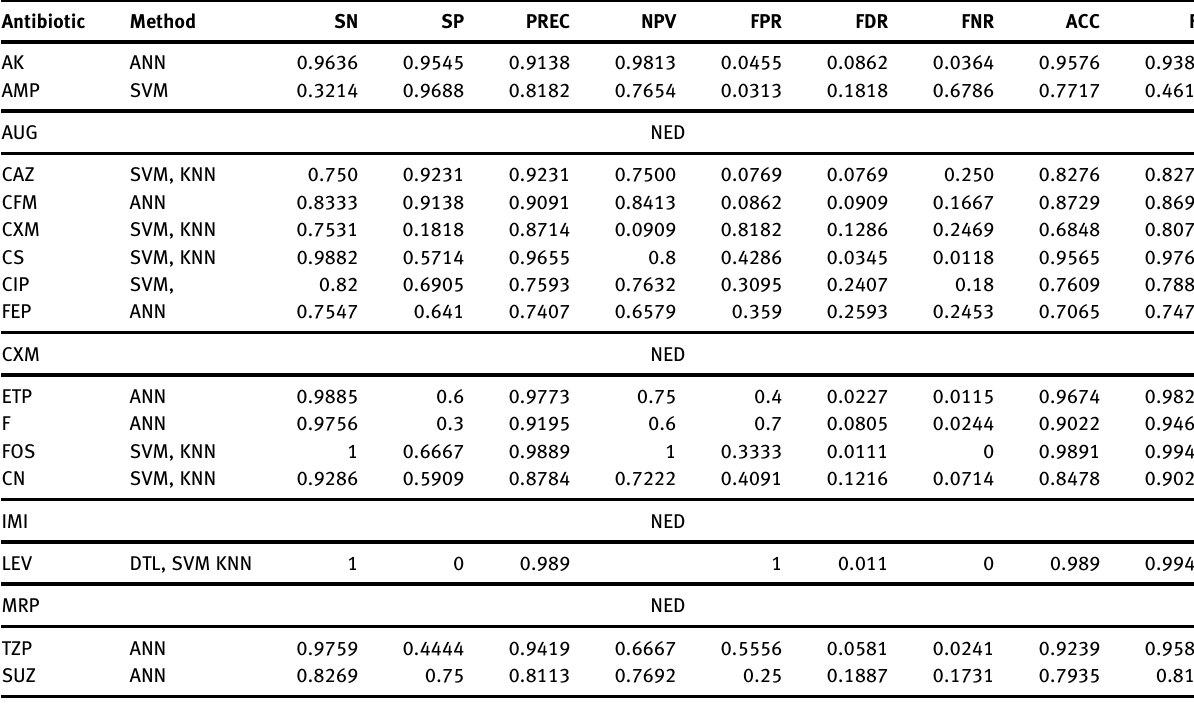
Table  : Performance results of the antibiotics. Antibiotic